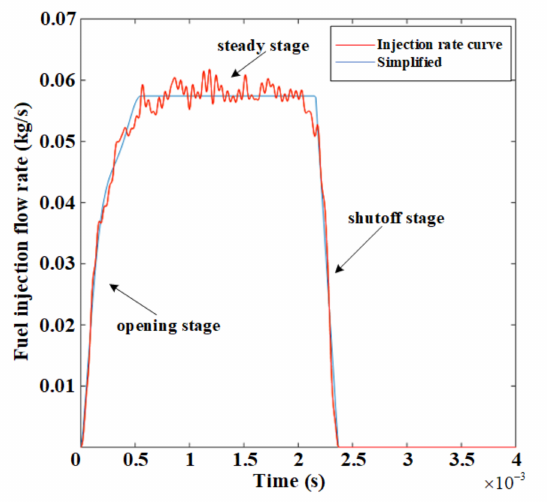
Figure 15. Simplified sketch of the fuel injection